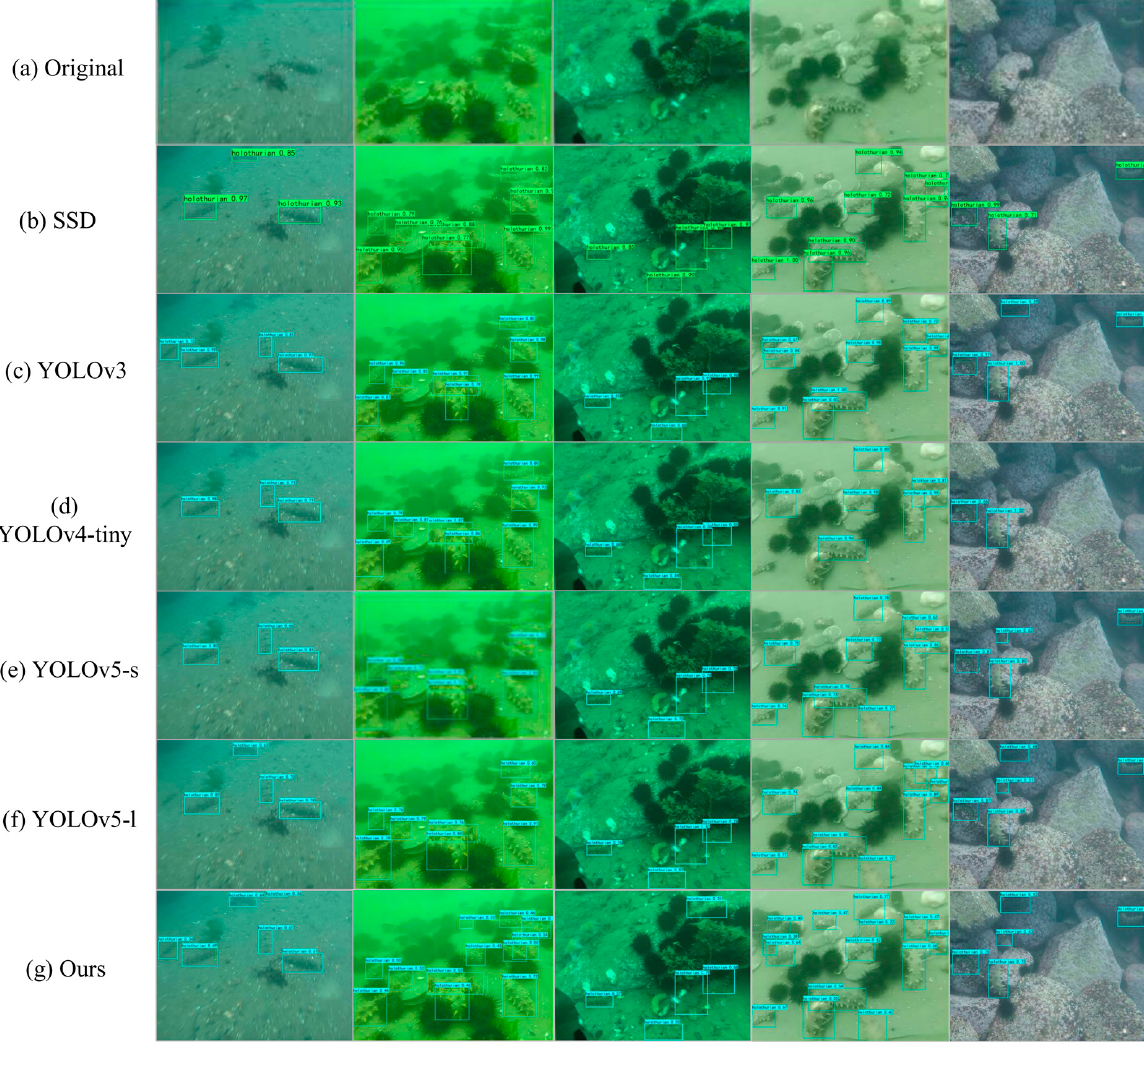
Figure 11. Performance of different detection methods in CURPC 2020 datasets. ( a ) Original Input Pictures. ( b ) Results of SSD. ( c ) Results of YOLOv3. ( d ) Results of YOLOv4-tiny. ( e ) Results of YOLOv5-s. ( f ) Results of YOLOv5-l. ( g ) Results of FA-CenterNet.